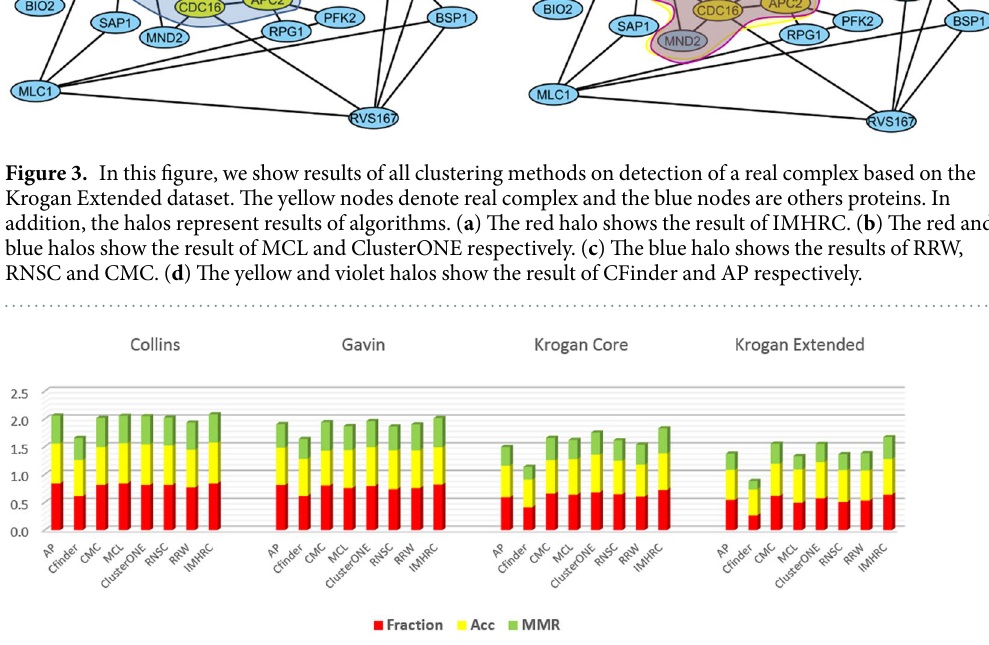
Figure 4. Modules obtained by different methods. Comparison of the total performance of all methods used in the evaluation on all datasets and using the SGD gold